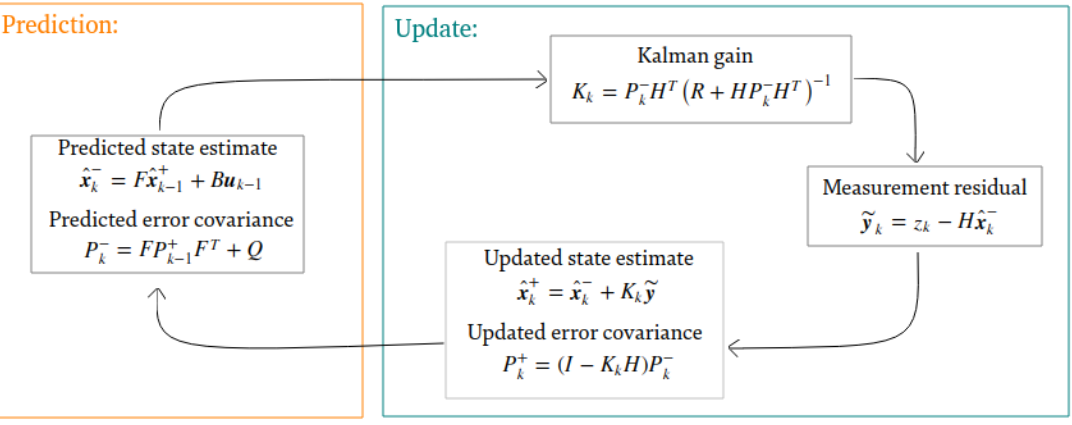
Figure 7. Kalman